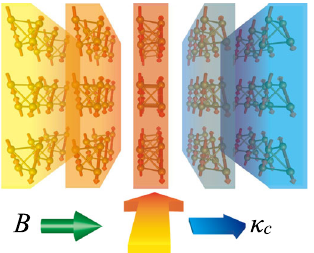
Fig. 6 Concept of magnetic- fi eld control of thermal conductivity. When magnetic- fi eld B is applied horizontally along one of the cubic axes of pharmacosiderite in its q = 0, Γ 5 magnetic order, magnon excitations are con fi ned in each vertically aligned layer; this selection of the magnetic c axis occurs because the parasitic ferromagnetic moment along the c axis prefers the fi eld direction even if B is as small as 0.5 T. Because magnons can carry a heat fl ow, the thermal conductivities κ a and κ c become large and small along directions perpendicular and parallel to B , respectively, which results in a large horizontal temperature gradient, as depicted by the variation in colour. When B is rotated to the vertical direction, the anisotropic thermal conduction is reversed. Thus, a switching of thermal conductance becomes possible via the external magnetic fi